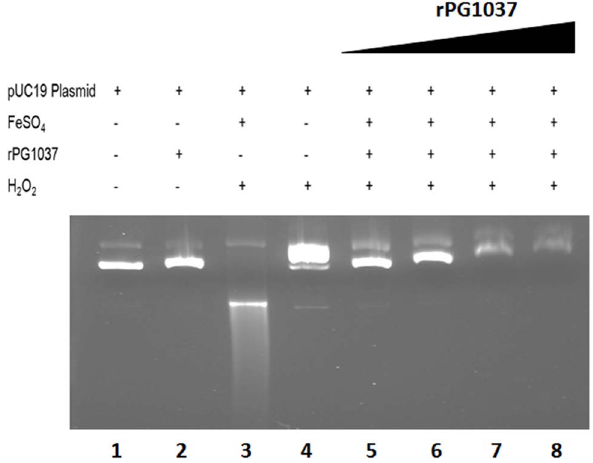
Figure 9. rPG1037 prevents Fenton chemistry-mediated DNA damage in vitro . The 1% agarose gel shown was loaded with various reaction components, with protein concentrations increasing as indicated. Lane 1 contains pUC19 plasmid; Lane 2 contains pUC19 and rPG1037 only; Lane 3 shows degradation of the pUC19 plasmid in the presence of FeSO 4 and H 2 O 2 ; Lane 4 shows degradation of the pUC19 plasmid in the presence of H 2 O 2 only; Lanes 4–8 shows that increasing concentrations of rPG1037 (1 m g, 2 m g, 3 m g and 4 m g) abrogates the effect of FeSO 4 and H 2 O 2 and results in retardation of pUC19 plasmid through the agarose gel. When present, FeSO 4 was at 50 m M and hydrogen peroxide was at 880 mM final concentration.